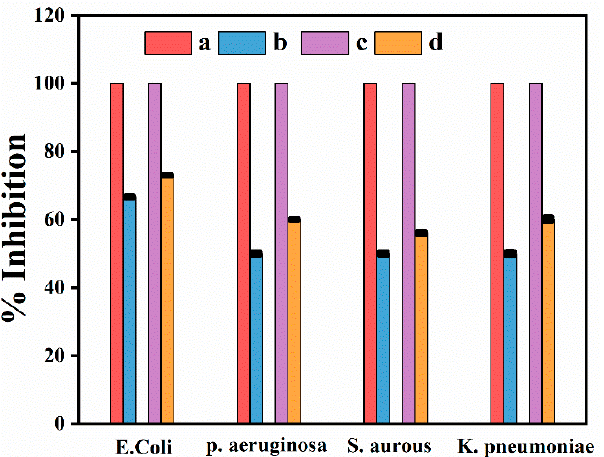
Figure 8. Antibacterial activities of root and leaf stabilized Ag NPs. (a) standard, (b) L-Ag-NPs, (c) Standard (Levofloxacin) and (d) R-Ag-NPs.